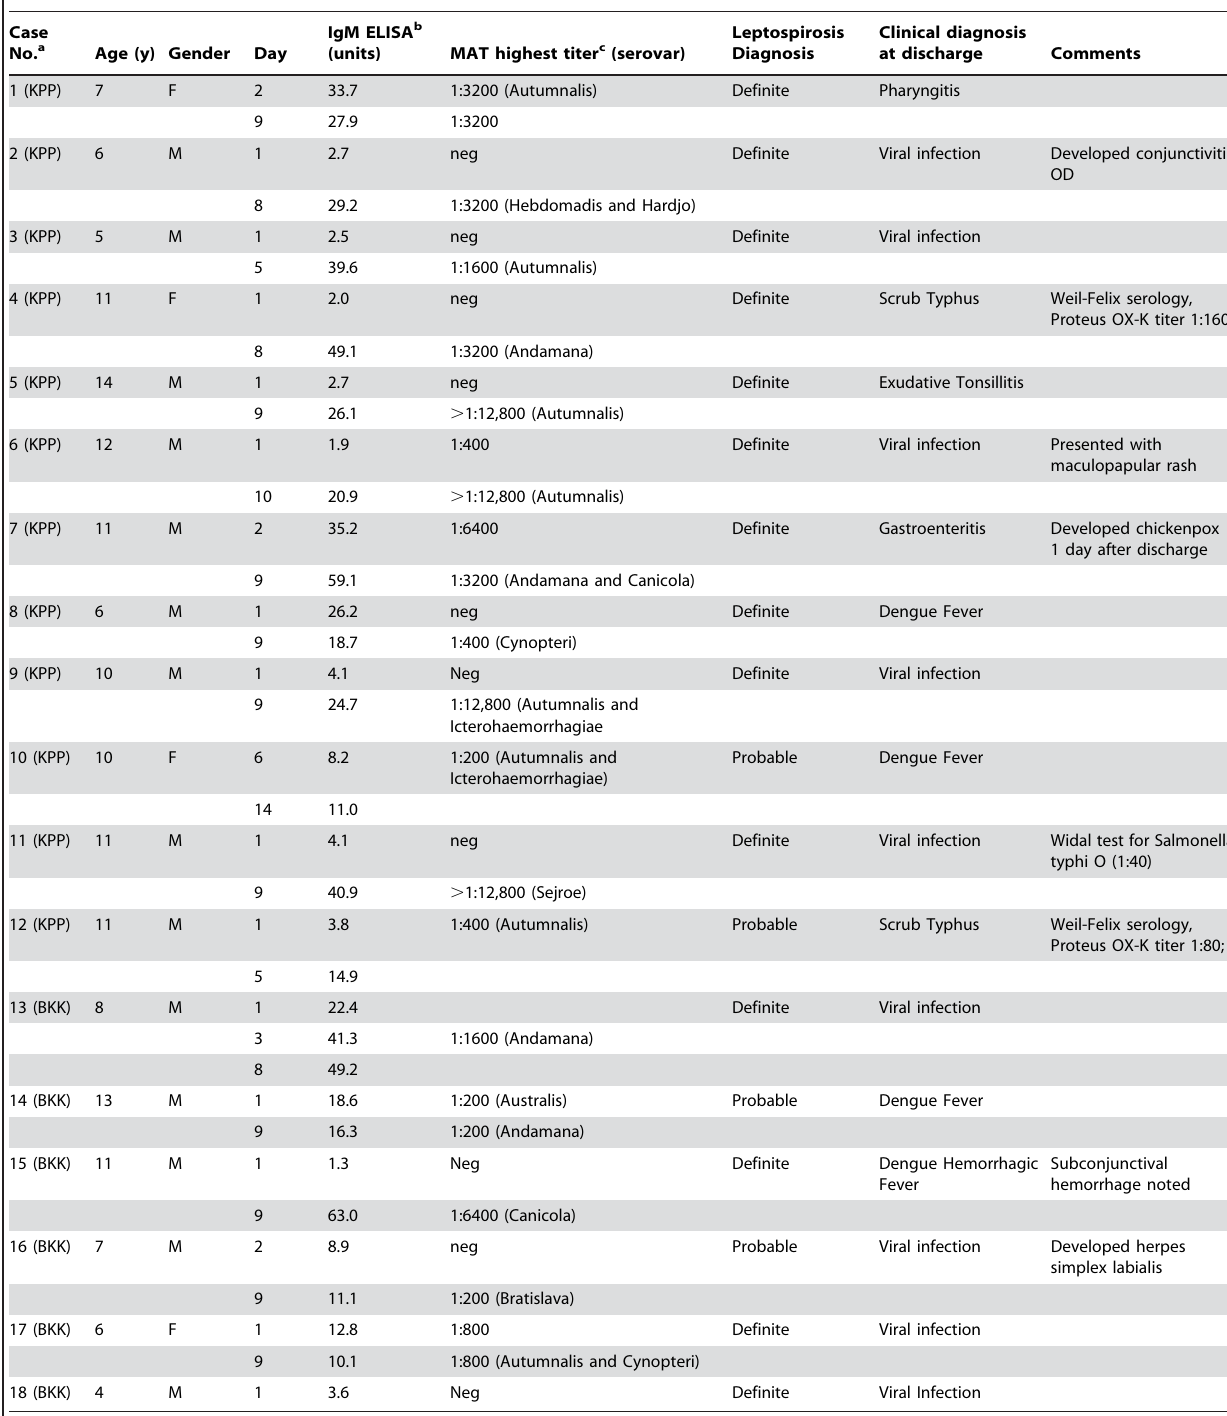
Table 1. Summary of the pediatric leptospirosis cases.